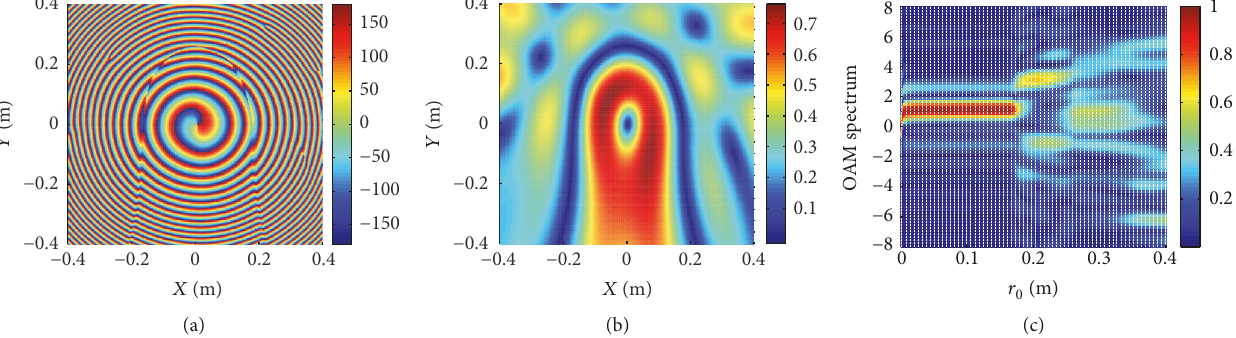
Figure5:(a)Phaseprofile,(b)intensitypattern,and(c)theOAMspectrumafterutilizingradioOAMsteeringtogeneratemode1at (60 ∘ , 60 ∘ )